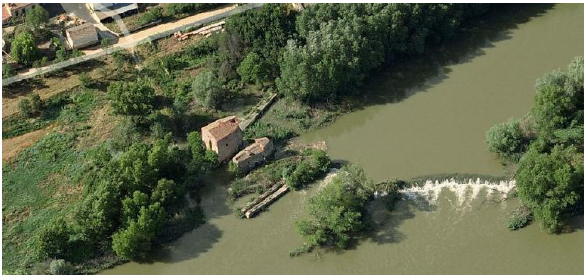
Figure 2: Aerial view of Pisones Dam